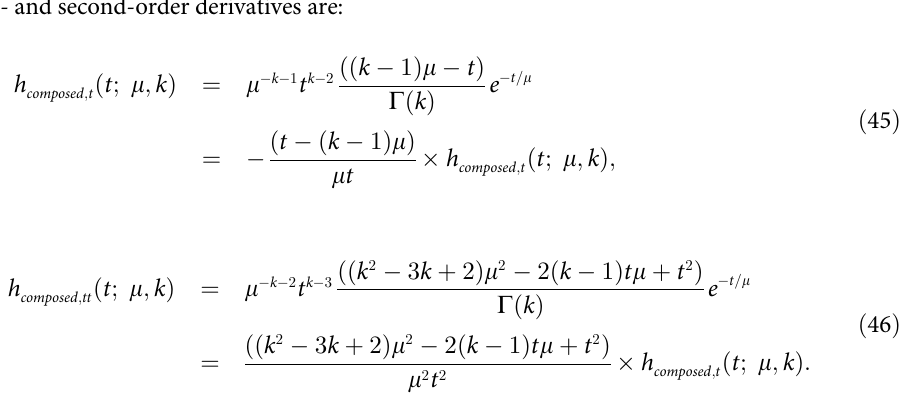
ffiffiffiffiffiffiffiffi p 1 = 4 . (bottom row) k = 7 and m ¼